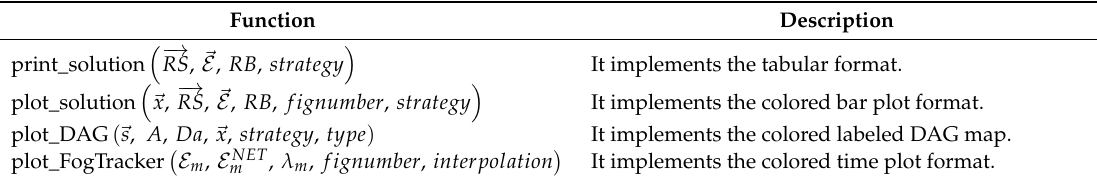
Table 5. Rendering functions for the supported formats implemented in VirtFogSim . Function